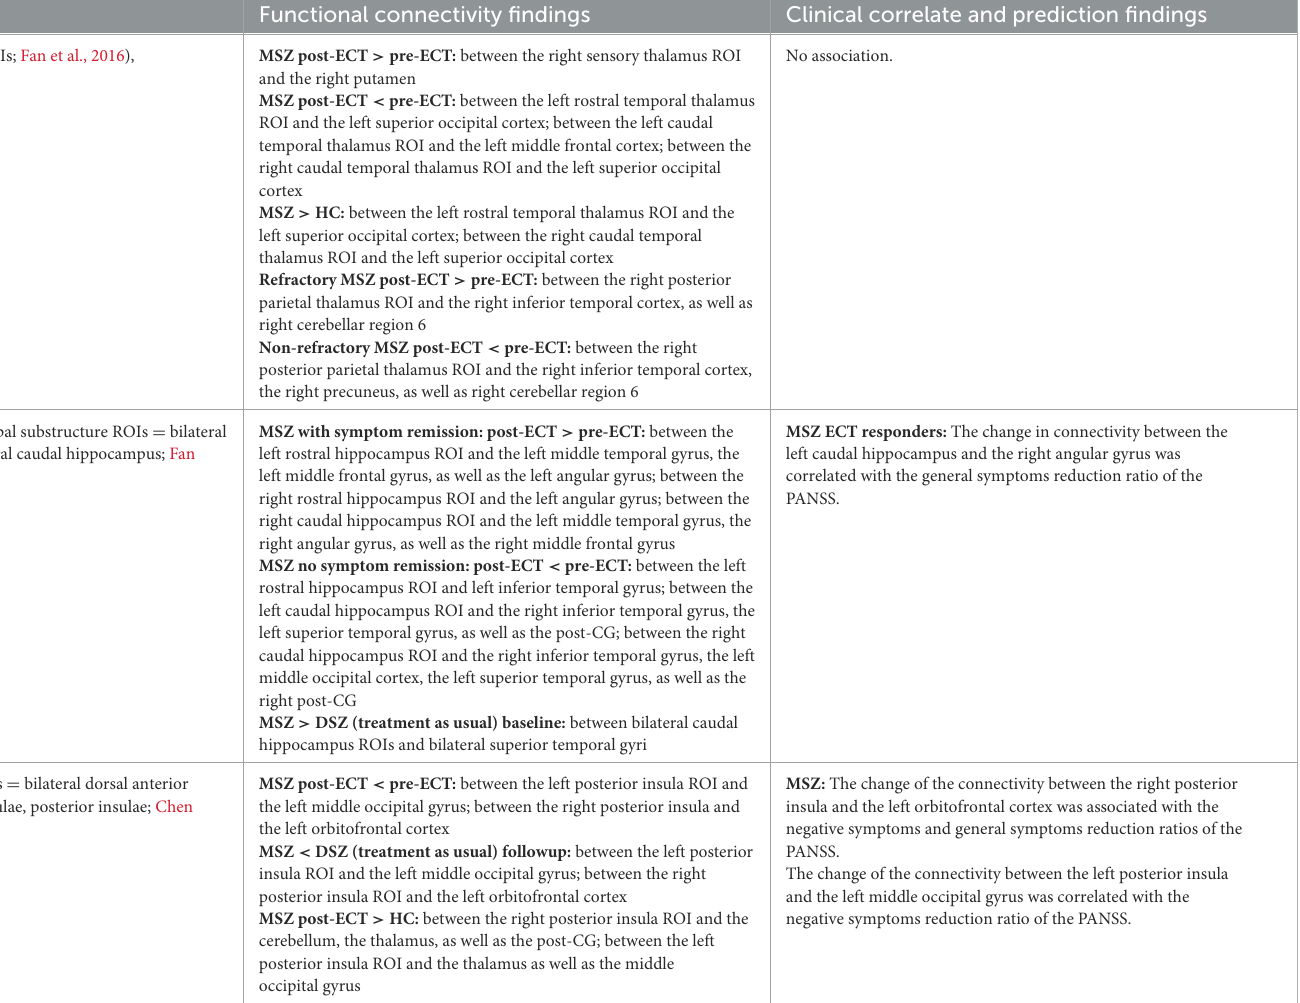
MSZpost-ECT < pre-ECT: between the left rostral temporal thalamus ROI and the left superior occipital cortex; between the left caudal temporal thalamus ROI and the left middle frontal cortex; between the right caudal temporal thalamus ROI and the left superior occipital cortex MSZ > HC: between the left rostral temporal thalamus ROI and the left superior occipital cortex; between the right caudal temporal thalamus ROI and the left superior occipital cortex Refractory MSZ post-ECT > pre-ECT: between the right posterior parietal thalamus ROI and the right inferior temporal cortex, as well as right cerebellar region 6 Non-refractory MSZ post-ECT < pre-ECT: between the right posterior parietal thalamus ROI and the right inferior temporal cortex, the right precuneus, as well as right cerebellar region